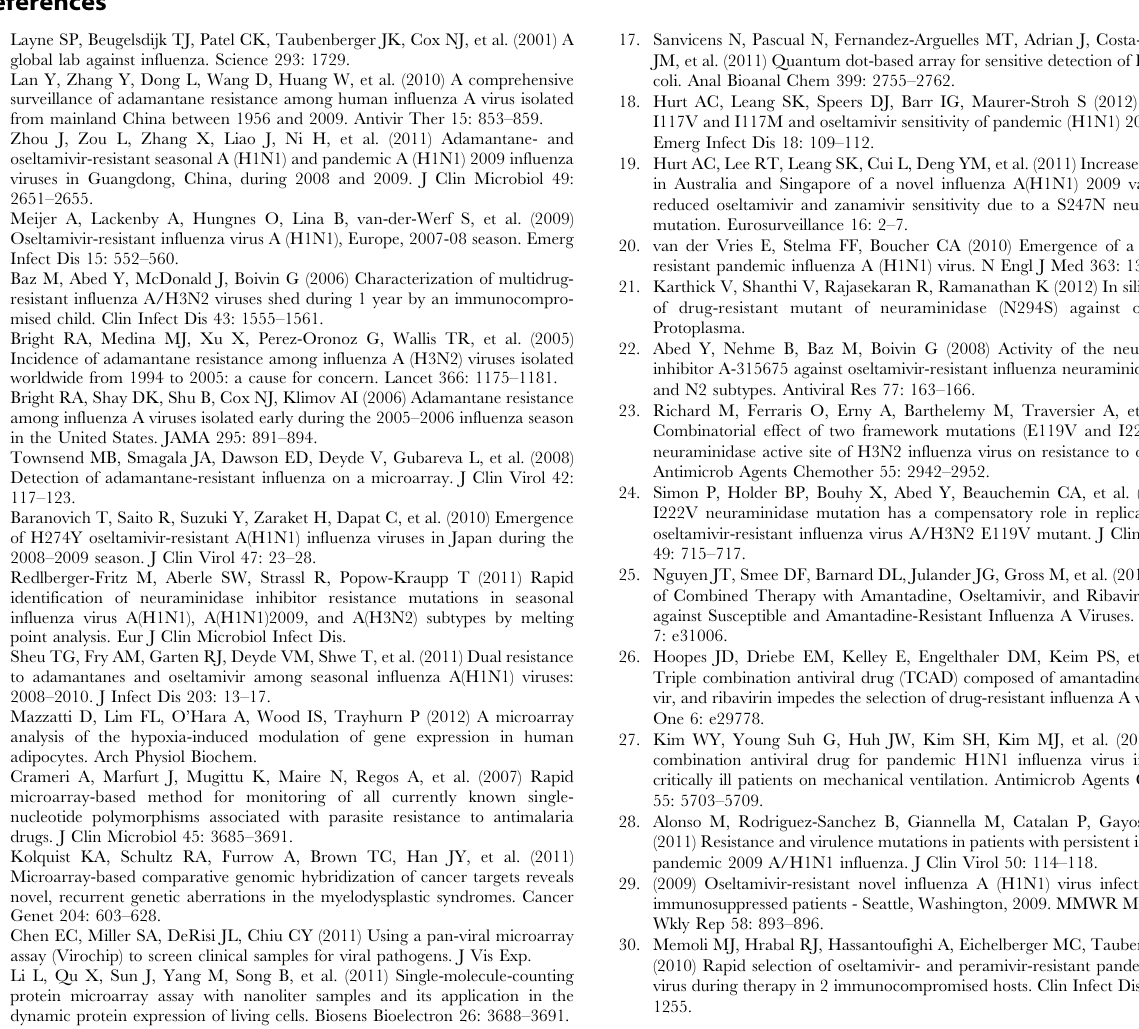
Figure S4 The sequencing results of 161 positive samples of influenza A virus. 144 2009 influenza A